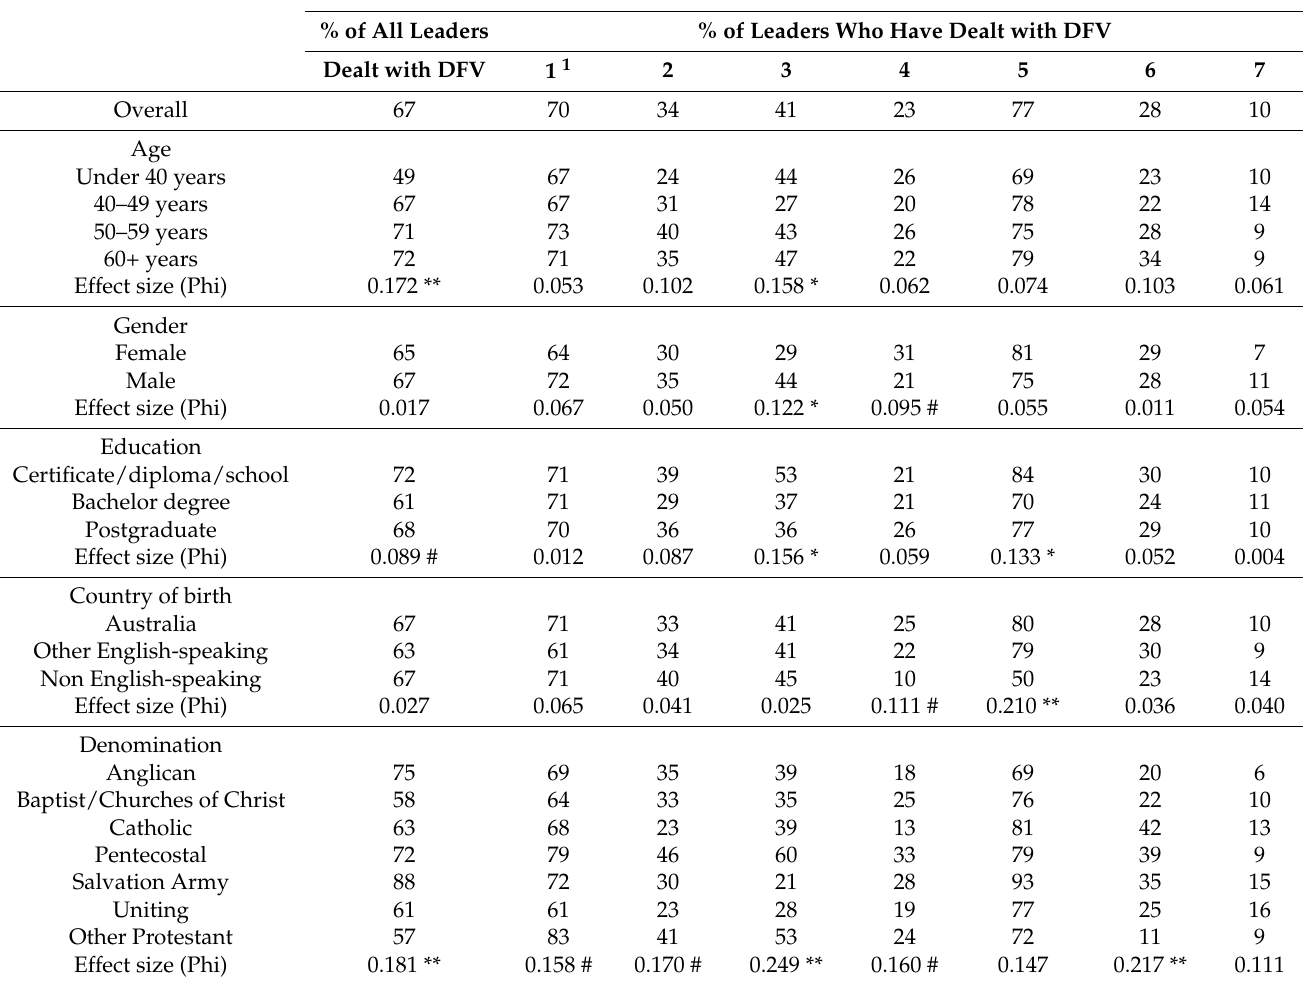
Table 4. Senior local church leader responses when dealing with DFV situations by demographics and